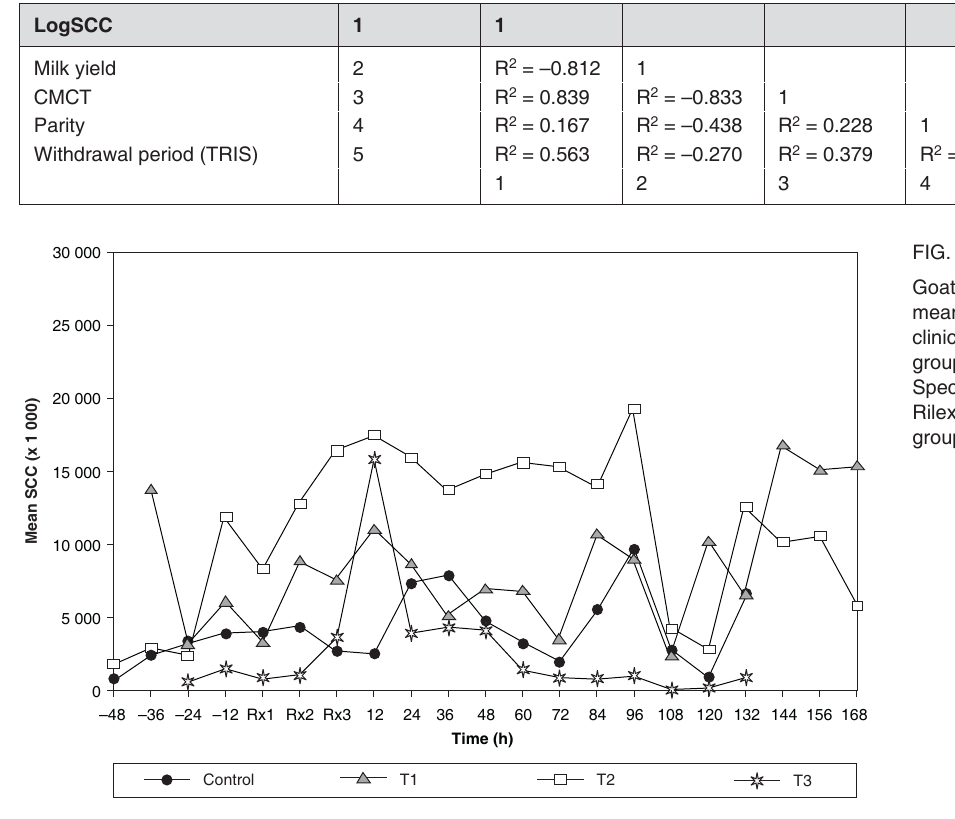
TABLE 5 Goats with clinical mastitis: Correlation matrix (Curaclox LC, Spectrazol & Rilexine) including withdrawal period as meas- ured by TRIS (degrees of freedom = 16) LogSCC